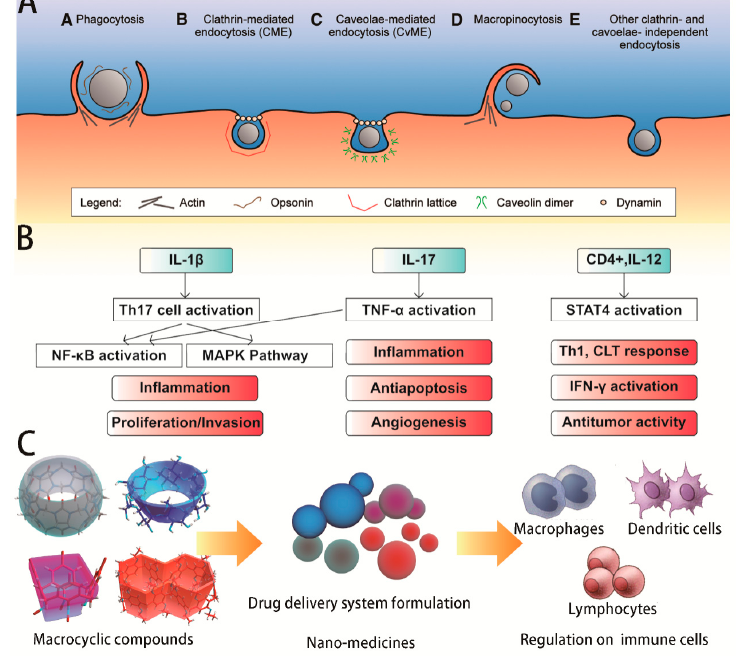
Figure 3. ( A ) Nanocarriers can be internalized into cells via several mechanisms, including phagocytosis and non-phagocytic pathways such as macropinocytosis, clathrin-mediated endocytosis (CME) and caveolae-mediated endocytosis (CvME). (Reprinted by permission from Springer Nature: Cellular and Molecular Life Sciences, Nanocarriers’ entry into the cell: relevance